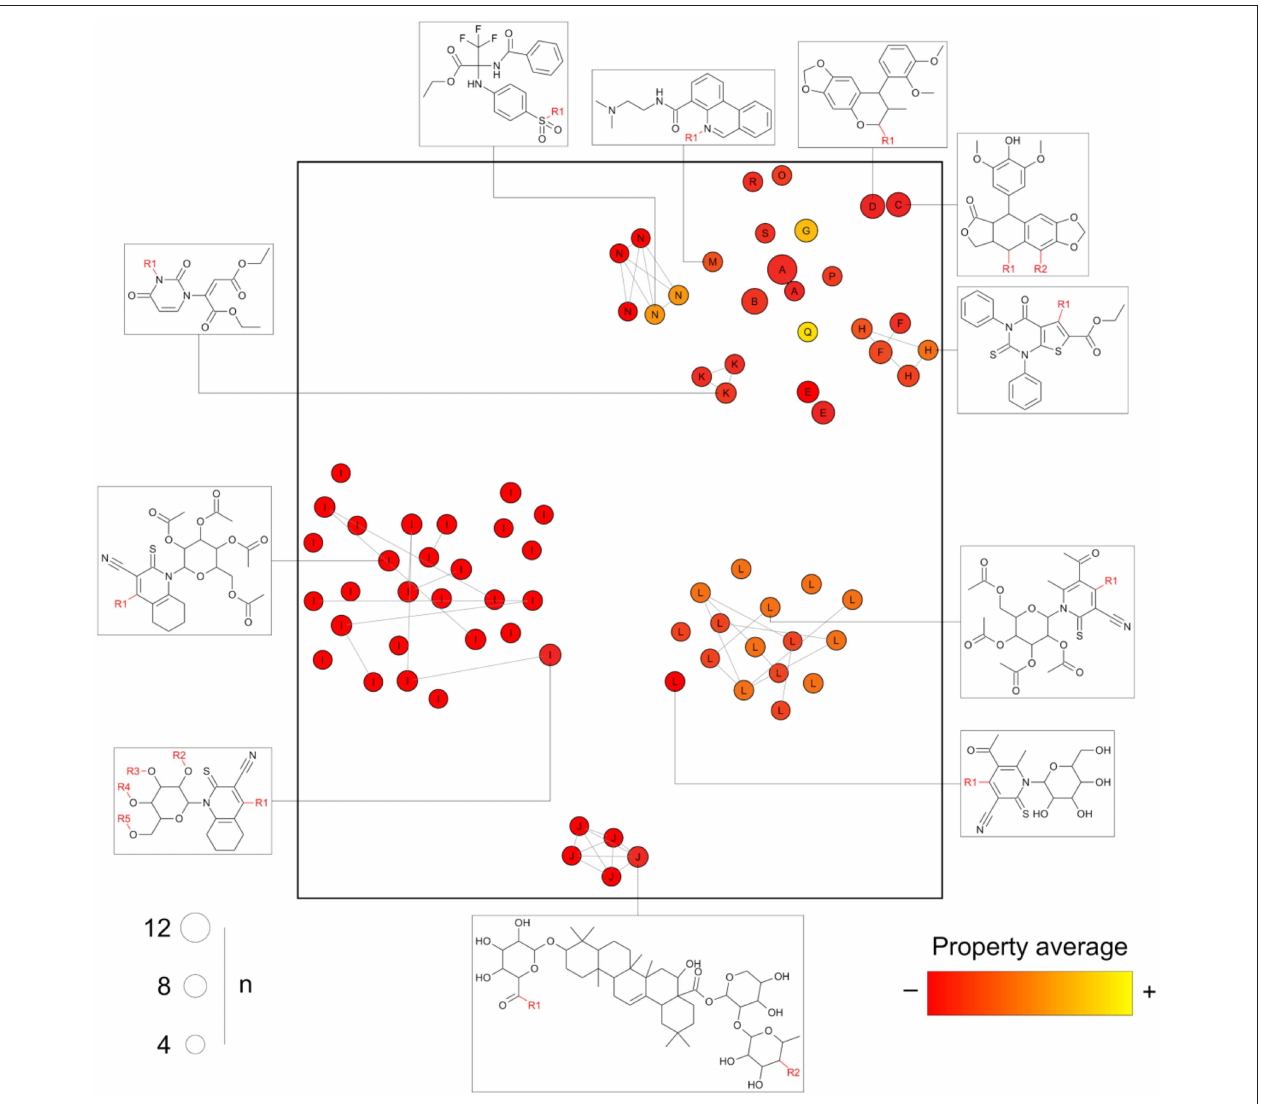
FIGURE 4 | Schematic representation of a general form of a constellation plot. Every circle in the plot represents a core; the axes comprise the coordinates of the chemical structure of the core projected into a 2D representation of the chemical space as computed by any of the standard approaches (e.g., generated using continuous properties or molecular fingerprints and applying t -SNE or principal components analysis); the size of the circles indicates the “n” number of compounds annotated to a given core; connected circles are cores sharing compounds; the labels indicate the analog series every point belongs to; the color scale represents the average of a property/activity of the compounds mapping to the